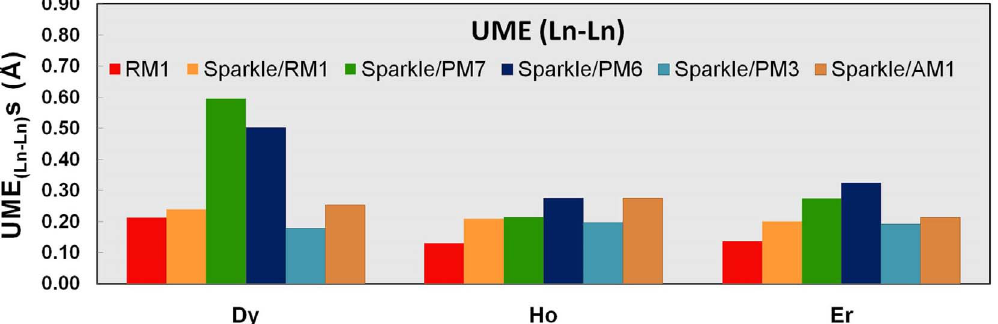
Figure 1. UME (Ln-Ln) s obtained using the RM1 model for the lanthanides and all five versions of the Sparkle Model: Sparkle/RM1, Sparkle/PM7, Sparkle/PM6, Sparkle/PM3 and Sparkle/AM1 for all complexes of the universe set for each of the lanthanide trications: Dy(III), Ho(III) and Er(III). The UMEs are calculated as the absolute value of the difference between the experimental and calculated Ln- Ln interatomic distances, summed up for all complexes, for each of the lanthanides.